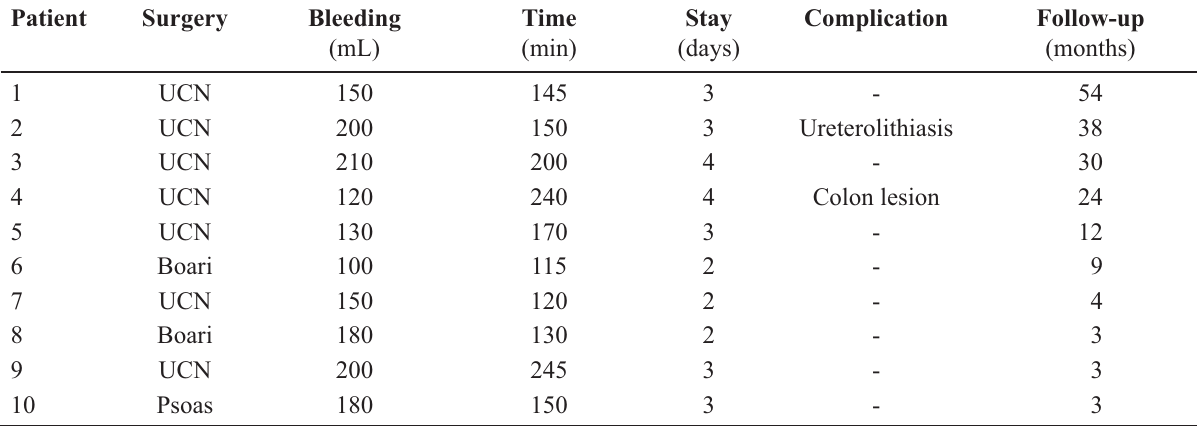
Table 2 – Postoperative clinical data.